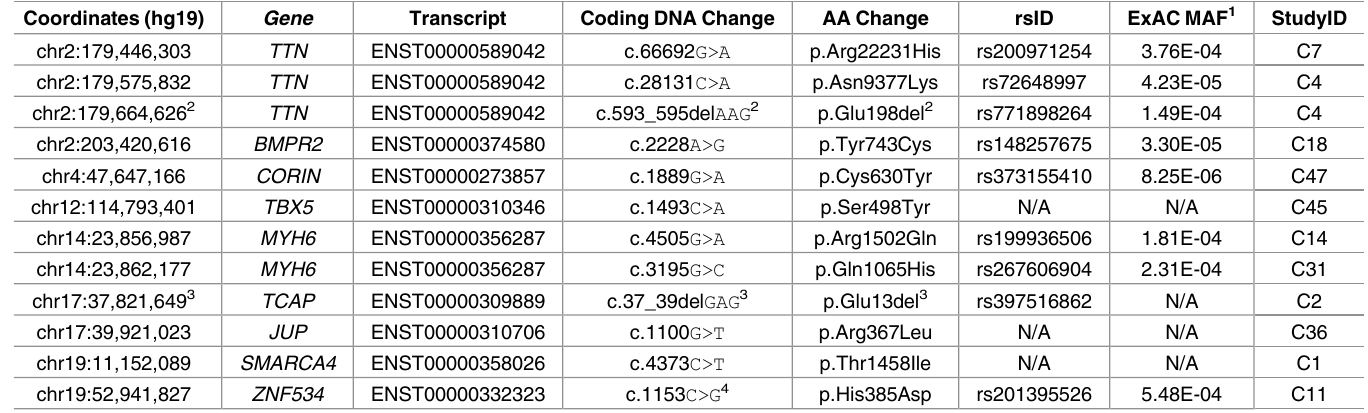
Table 4. Rare sequence variants validated in candidate EA